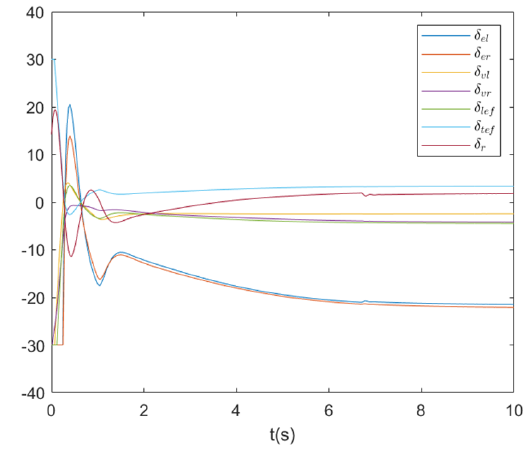
Figure 10. Actuator actions of Fighter 4.